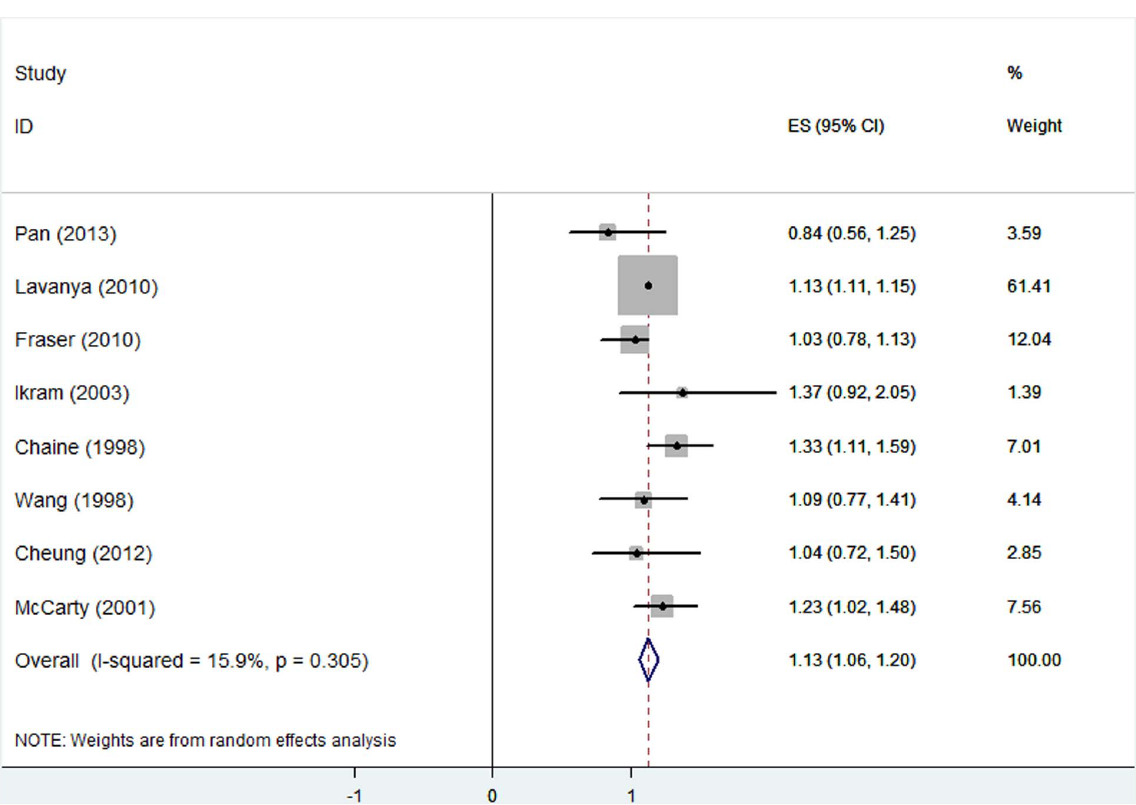
Figure 2. Hyperopia and prevalent early AMD: forest plot of pooled odds ratios for the random-effects meta-analysis of early AMD prevalence and hyperopia. CI, confidence interval.